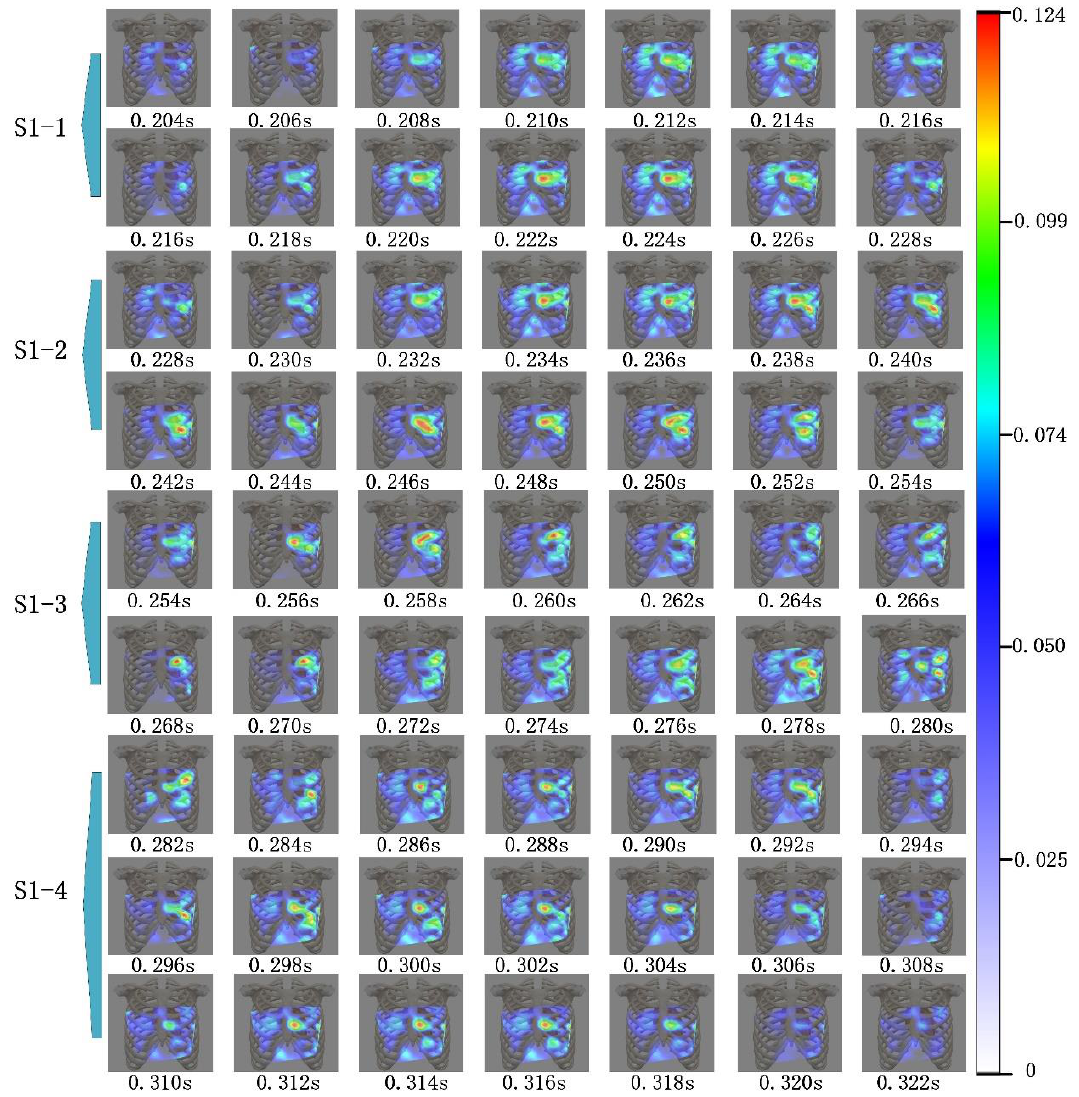
Figure 12. Cardiac acoustic maps of S1. The stages S1-1, S1-2, S1-3, and S1-4 are indicated in Figure 11.